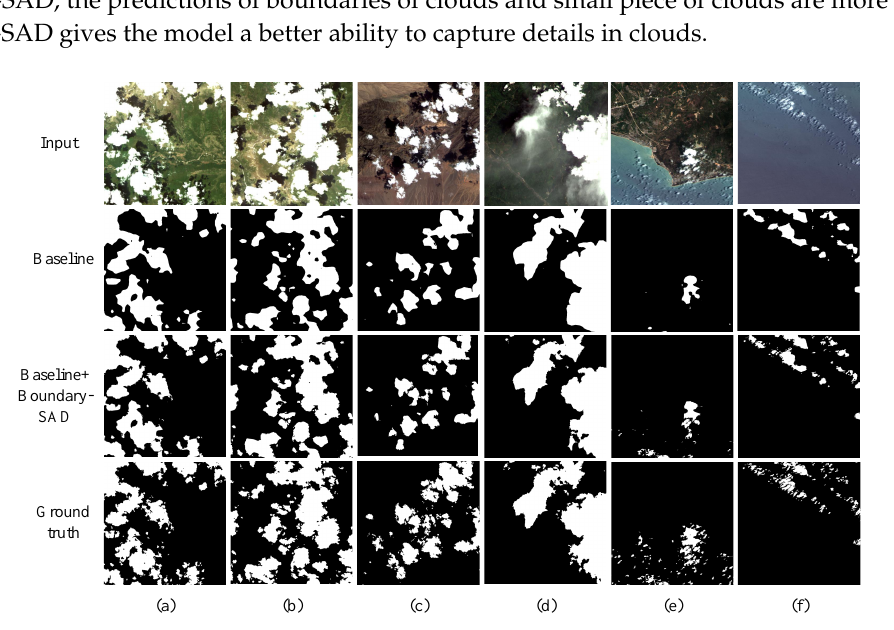
Figure 5. Visual comparison of the results for details in clouds. Training with Boundary-SAD, the network can capture details more accurately. ( a – c ) Mix of small cloud and big cloud. ( d ) Mix of big cloud and thin cloud. ( e , f ) Small piece of